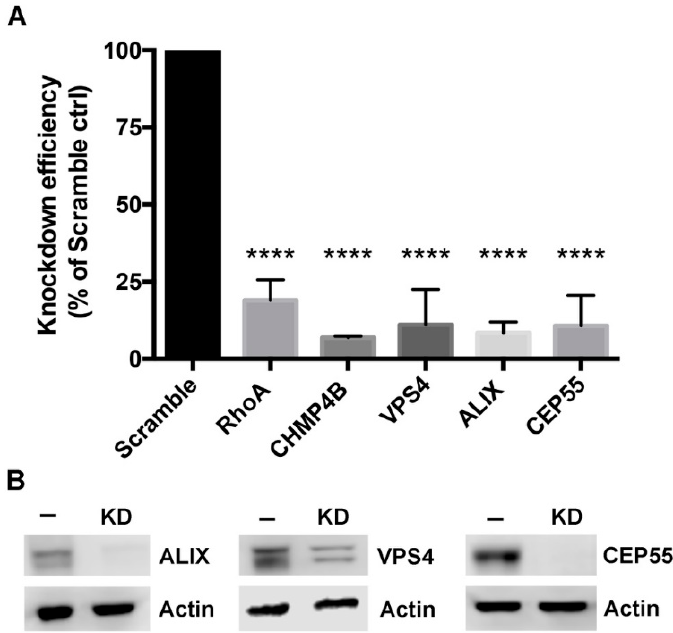
Figure 2. Knockdown of host abscission proteins. ( A ) Knockdown efficiency was measured by RT-PCR; values for each target are presented as a percent of gene expression compared to cells treated with a non-targeting siRNA (Scramble) control. Data points show mean ± SEM, n = 3. Statistics were performed using one-way ANOVA with Dunnett’s multiple comparisons post-test. **** denotes a p value < 0.0001. ( B ) HeLa cells treated with scramble siRNA ( − ), or treated with siRNA (KD) for VPS4, ALIX, or CEP55, and actin control.